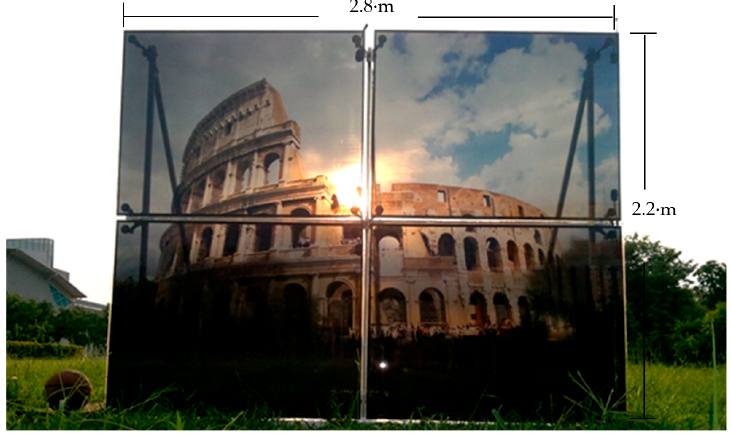
Figure 8. Annual power generation of opaque, 10% semi-transparent and artist PV modules installed with different tilt angles and orientations. The PV modules are installed in Changhua, Taiwan.